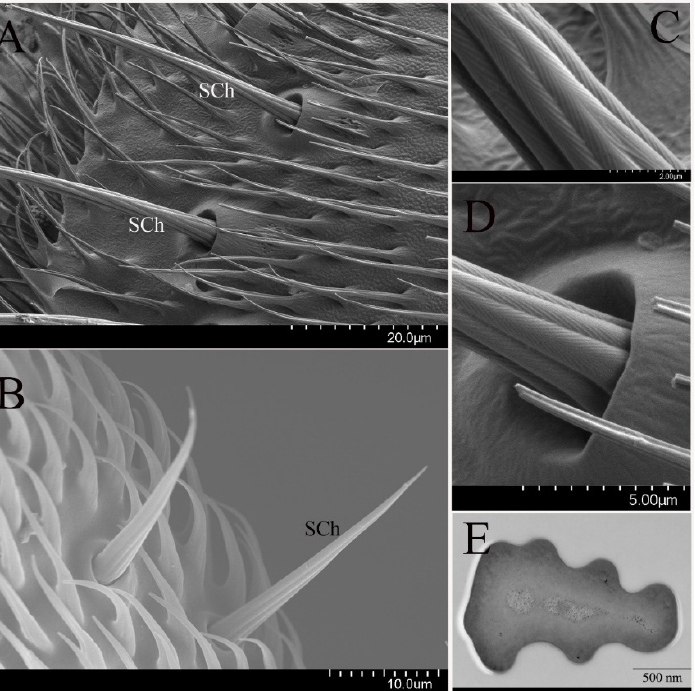
Figure 6. Sensilla chaetica (SCh) on B. dorsalis antenna ( A ), and maxillary palps ( B ), with pointed tips. ( C ) High magnification of longitudinal grooves lacking cuticular pores. ( D ) The morphological details of SCh surface showing the distinct basal socket. ( E ) Cross-section of SCh along the antenna show the thick cuticular wall, and no neuronal dendritic in the lumen.